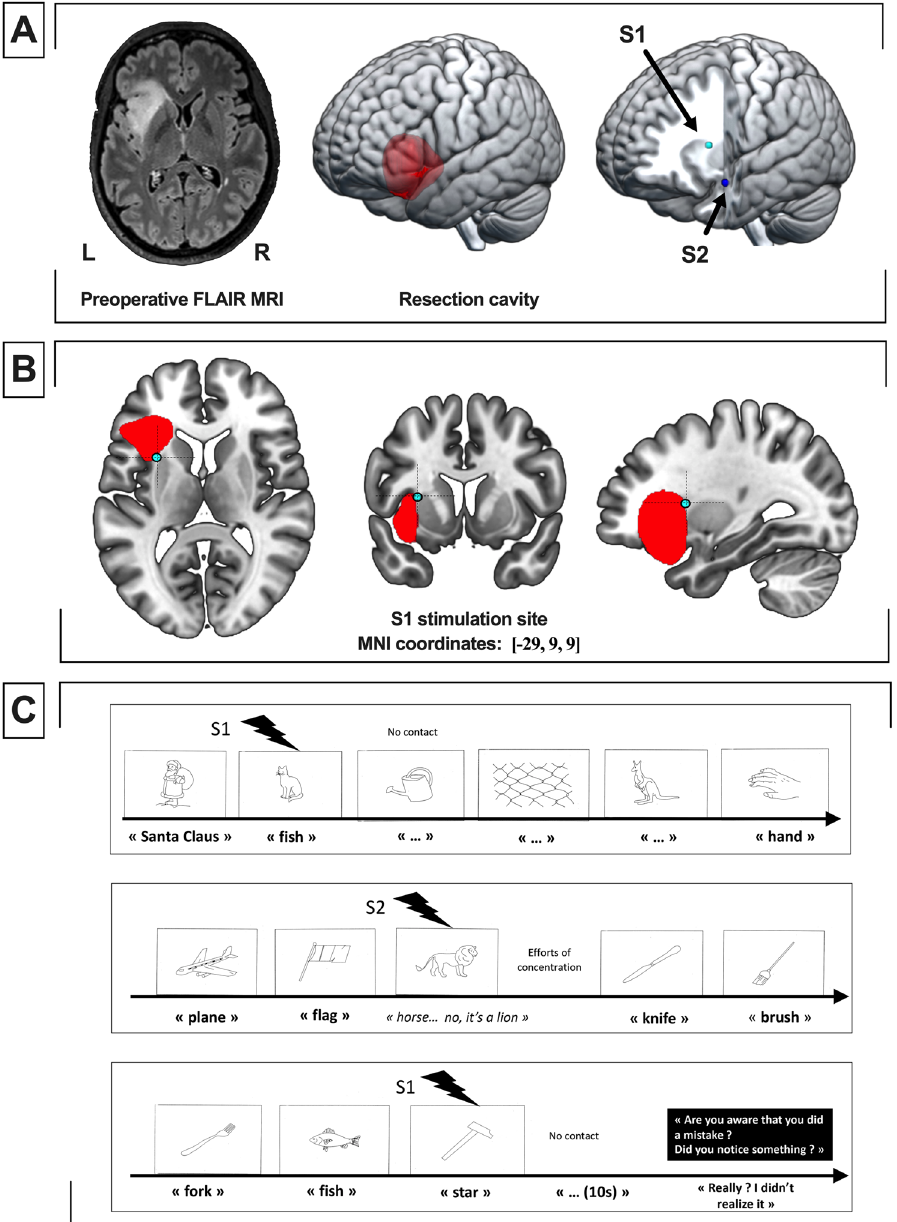
Figure 4. Case illustration 1. S1: Illustrative stimulation 1, generating verbal semantic disorders and a disruption of self-evaluative processing. S2: Illustrative stimulation 2, generating verbal semantic disorders without self-evaluative disturbances. ( A ) Preoperative FLAIR MRI axial sequence (left), 3D rendering of the resection cavity (center) and 3D rendering of the stimulation points S1 and S2. ( B ) Axial (left), coronal (center) and sagittal (right) location of S1 stimulation site. The cavity of resection is presented in red. ( C ) Schematic description of the intraoperative protocol (DO80 naming